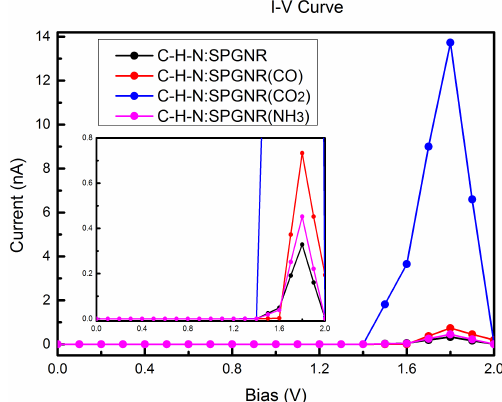
Figure 6: Calculated I-V curves for four struc- tures: C-H-N:SSPGNR, C-H-N:SSPGNR(CO), C-H- N:SSPGNR(CO 2 ) and C-H-N:SSPGNR(NH 3